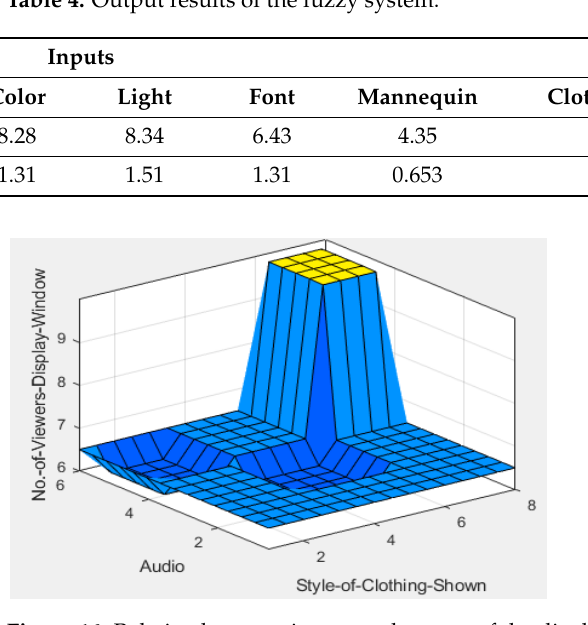
Table 4. Output results of the fuzzy system.